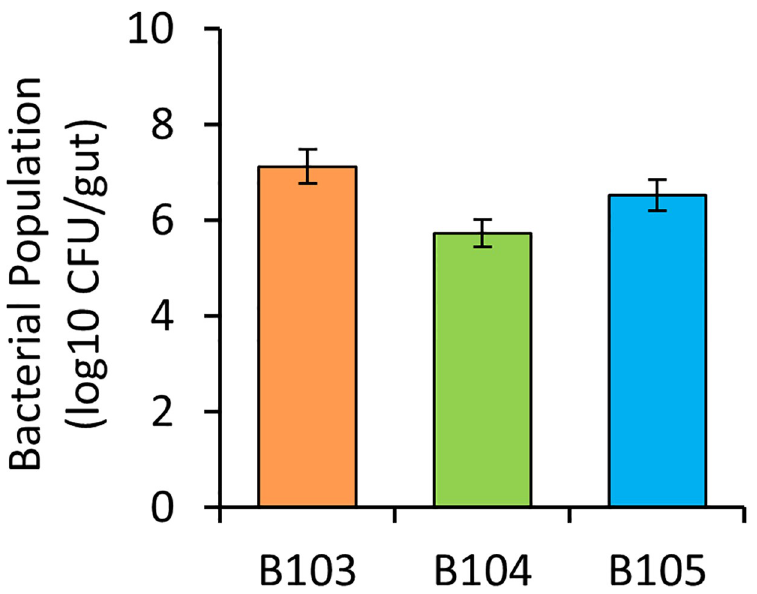
Fig 7. Colonizing populations of LAB in the guts of adult bean bugs. Second-instar nymphs were experimentally inoculated with LAB via feeding. At 21 days post-inoculation, adult bean bugs ( n = 5) were used for colony population monitoring. This experiment was performed twice each of which contained three technical replicates. Error bars indicate SD.